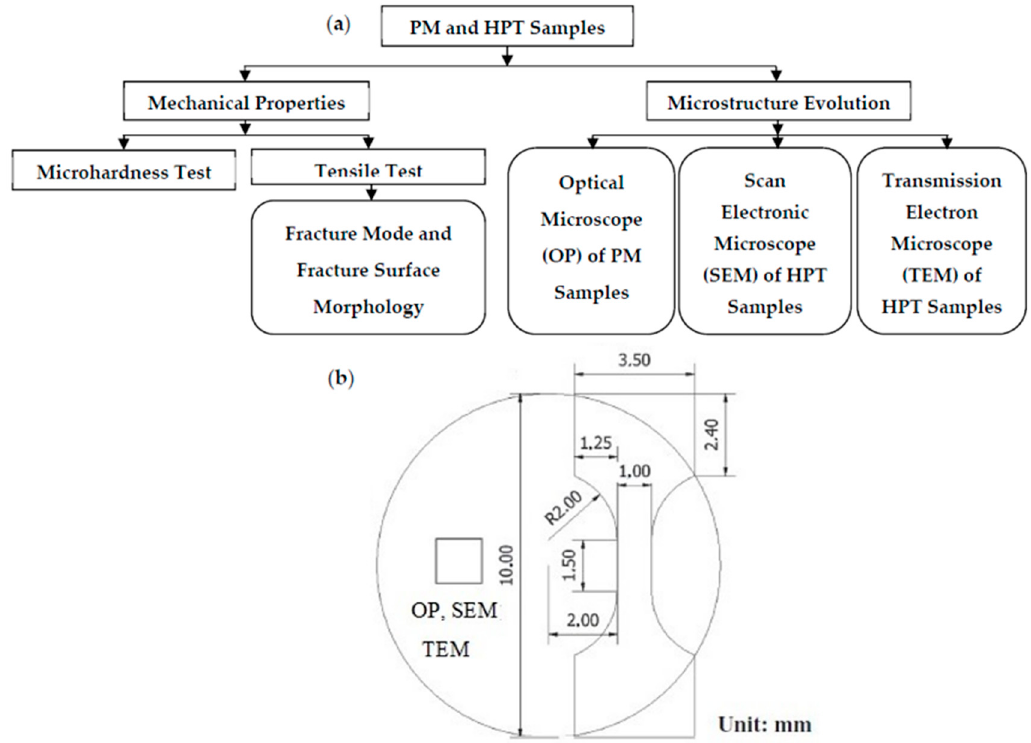
Figure 2. ( a ) Flow chart of the experimental testing; ( b ) the positions of the OP, SEM, and TEM observations; and tensile test sample. observations; and tensile test